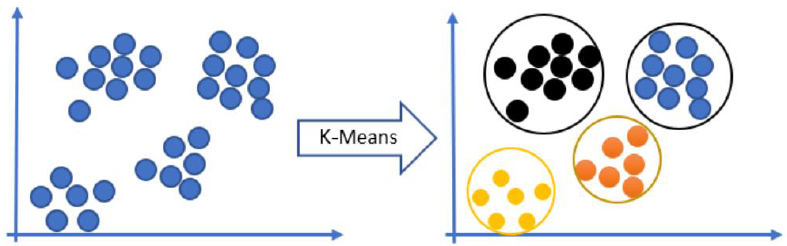
Figure 5. K-Means clustering model